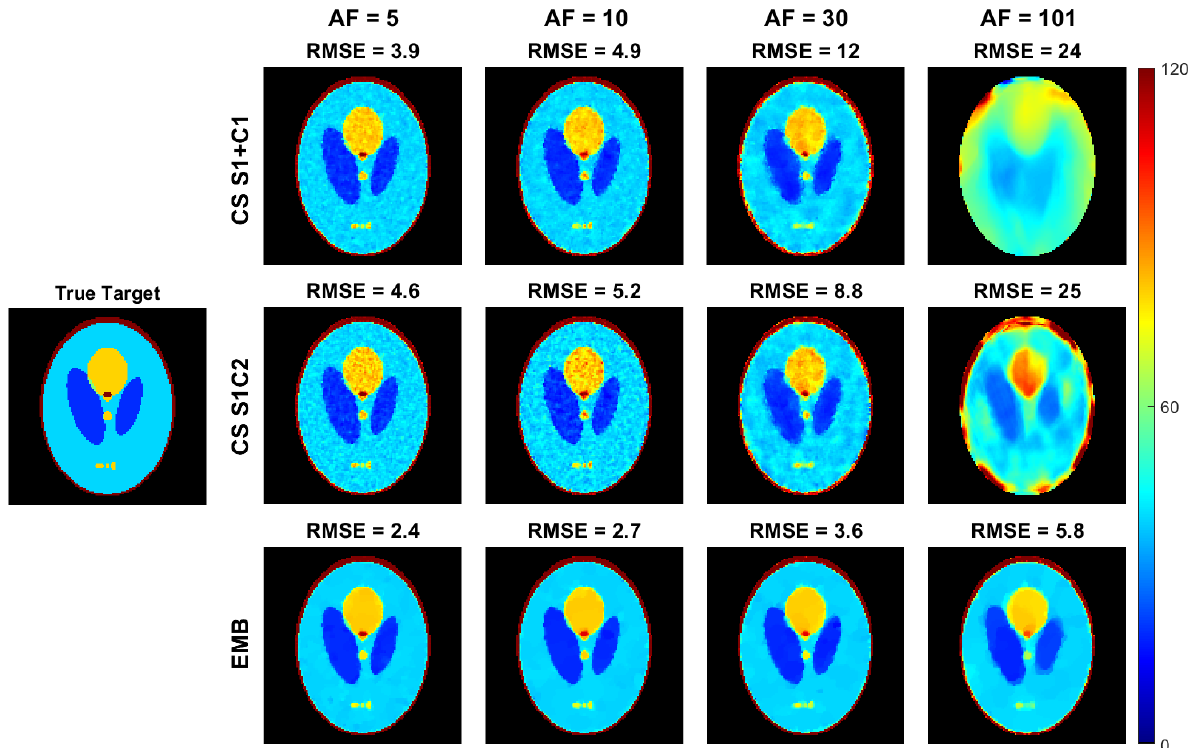
Figure 4. The T 1 ρ maps of the radial simulation reconstructed with the embedded model and the two CS models and the RMSEs of the reconstructions as compared to the true values used in the simulation. The top row contains the CS S1+C1 model and the middle row the CS S1C2 model T 1 ρ parameter maps obtained from the monoexponential fit of Equation (15), and the bottom row contains the embedded model reconstructions. Columns 2–5 show the T 1 ρ parameter maps at acceleration factors of 5, 10, 30, and 101. Images are cropped to